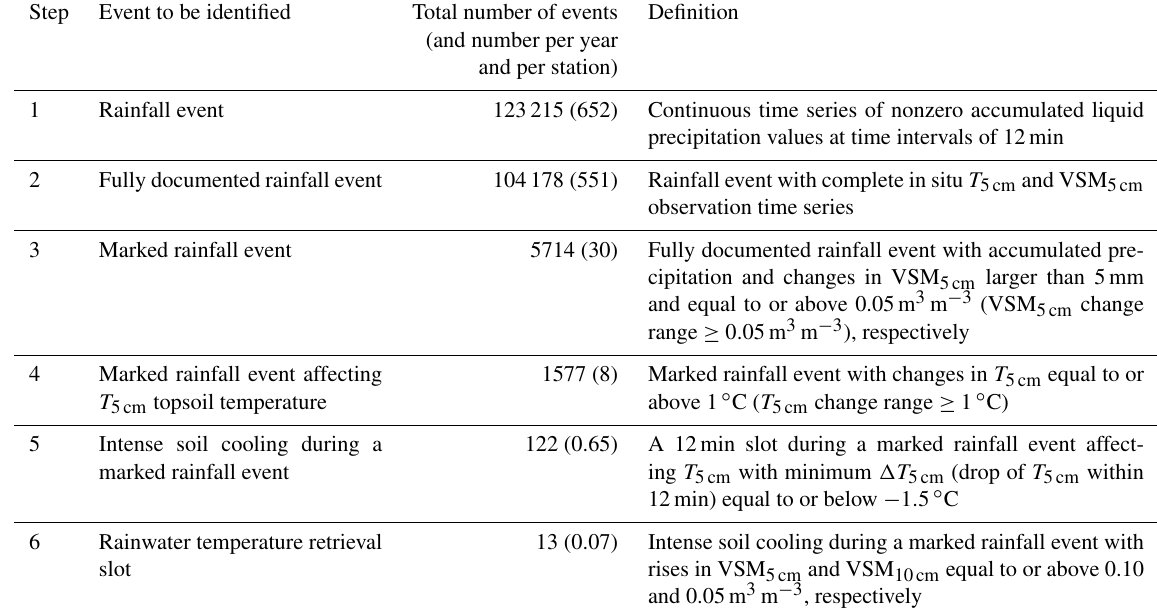
Table 2. Steps for identifying marked soil-cooling rains, together with the number of events for all the SMOSMANIA stations from 2008 to